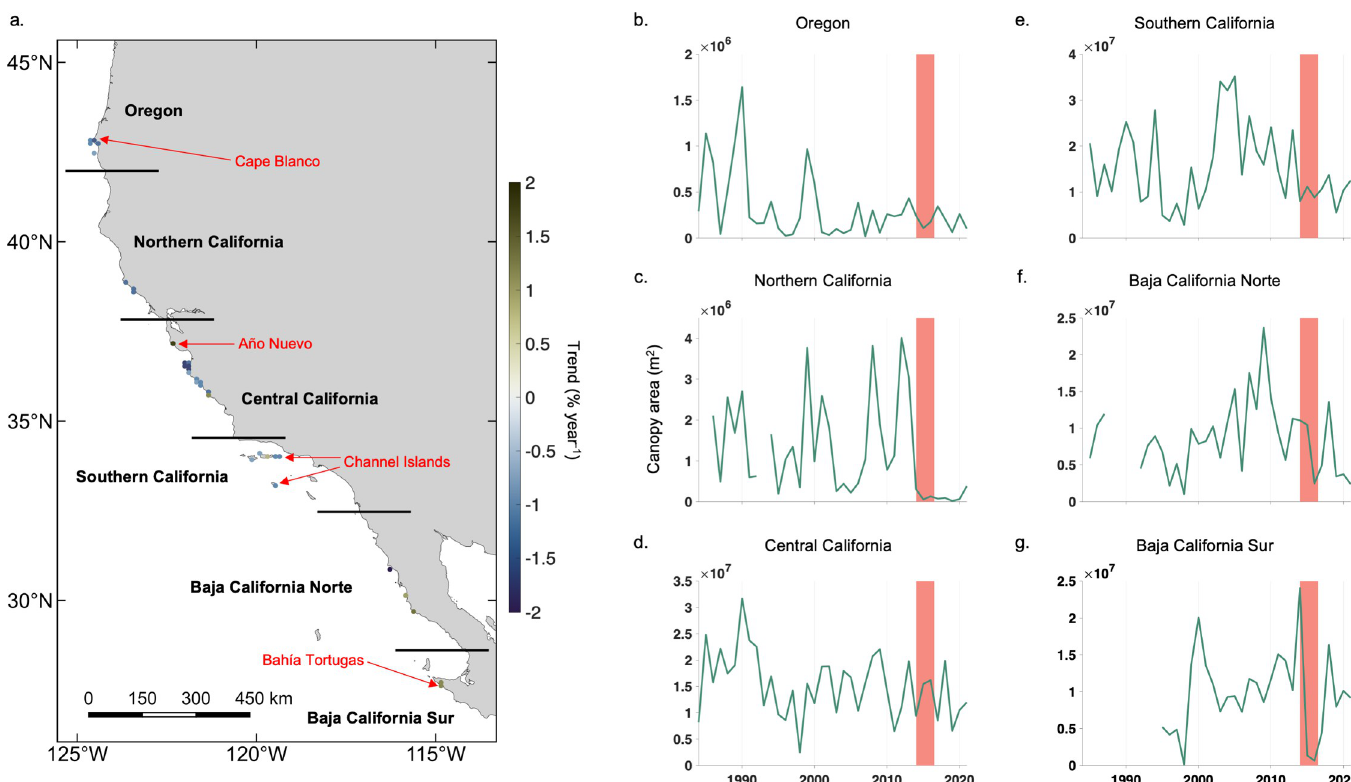
Fig 2. Study domain and regional time series. a.) Map of 10 x 10 km cells with significant long-term annual trends across the time series. Regions shown with the horizontal black lines. Place names are shown in red. Annual time series of kelp canopy area from each of the six study regions; b.) Oregon, c.) Northern California, d.) Central California, e.) Southern California, f.) Baja California Norte, g.) Baja California Sur. Vertical red bars show the timespan of the heatwave period (2014 to 2016). Basemap source: Natural